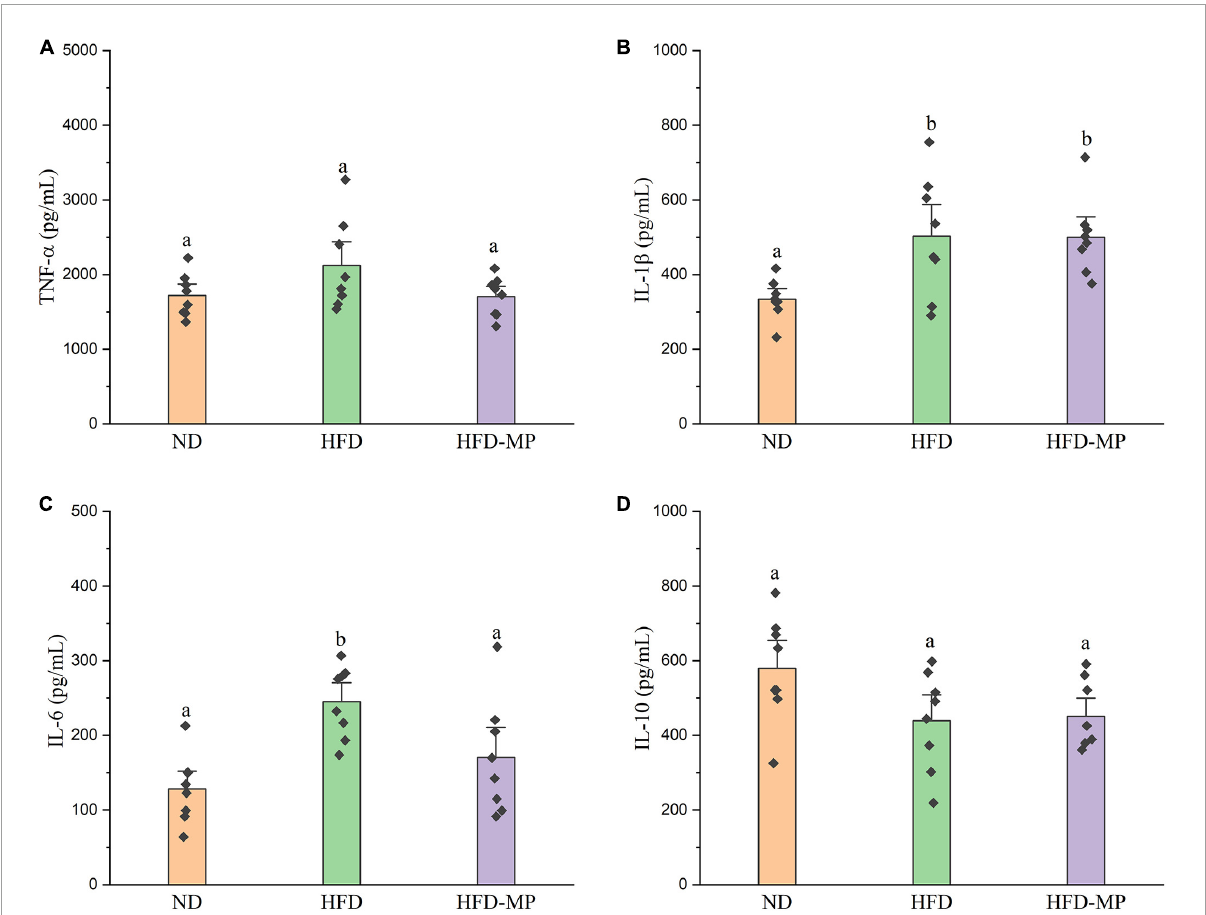
FIGURE3 MP intervention attenuated HFD-induced chronic inflammation, including (A) TNF- α , (B) IL-1 β , (C) IL-6, and (D) IL-10. The data are represented as the mean ± SEM. Statistical differences were carried out by one-way ANOVA followed by Tukey’s test, p < 0.05 indicates significant